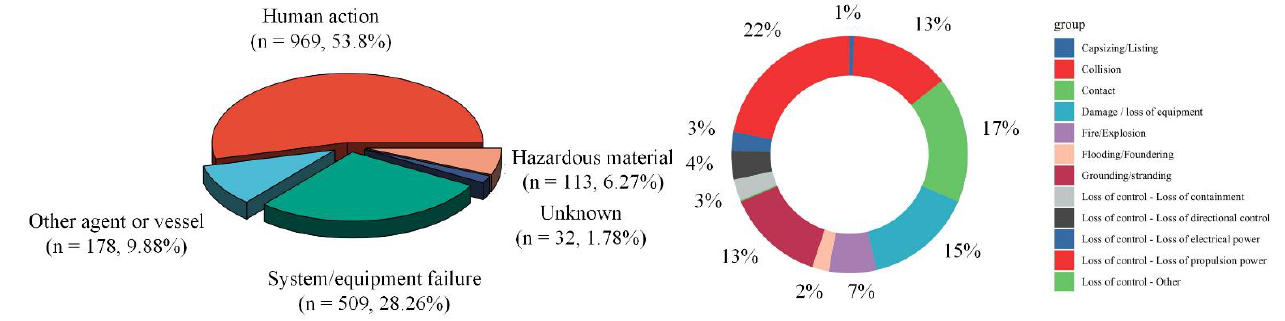
Figure 1. Distribution of accident events for the period 2014 – 2019.